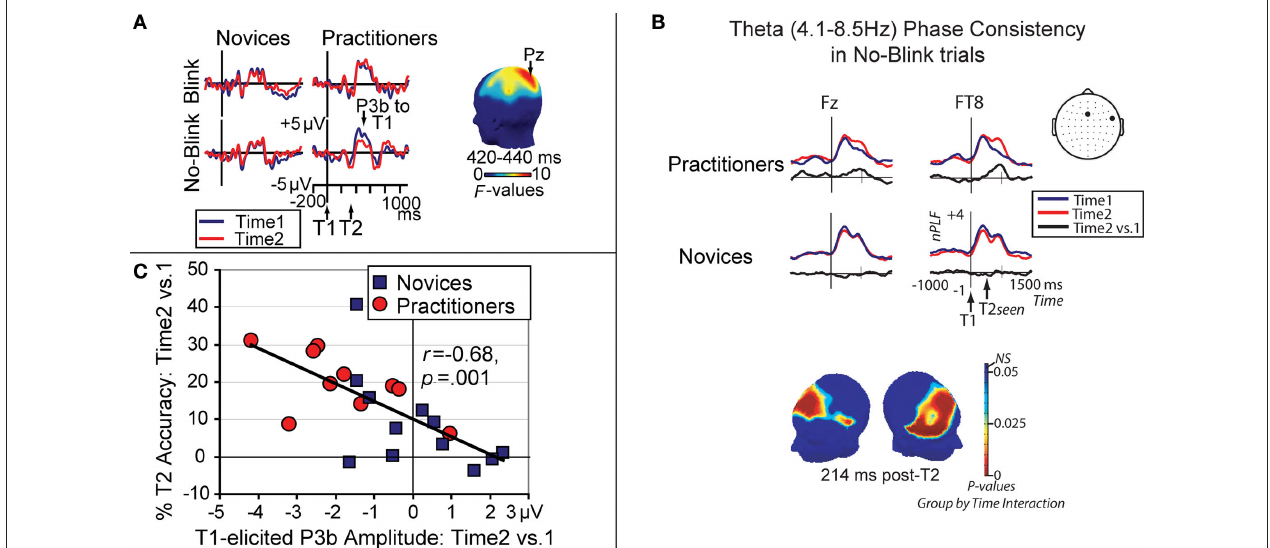
consistency was observed over midline frontal and right lateral frontal and centro-parietal scalp regions (see scalp map). This increase in phase consistency over time was only observed for the practitioner group, indicating that intensive OM meditation may have reduced trial-to-trial variability in the recruitment of processes leading toward the conscious perception of T2. Adopted from Slagter et al. (2009); (C) Relationship between the observed change in brain resource allocation to T1, as indexed by T1-elicited P3b amplitude (for no-blink trials), and the corresponding the change in attentional blink magnitude over time. Note that those individuals that showed the largest decrease in T1-elicited P3b amplitude over time generally showed the largest increase in T2 accuracy over time. Adopted from Slagter et al. (2007); together, these data support the notion that the ability to accurately identify T2 depends upon the efficient processing of T1, and that OM meditation may reduce elaborate object